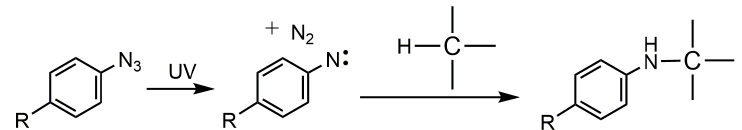
Figure 6. Mechanism of the formation of covalent bond between species bearing azide group and the compound with reactive hydrogen .